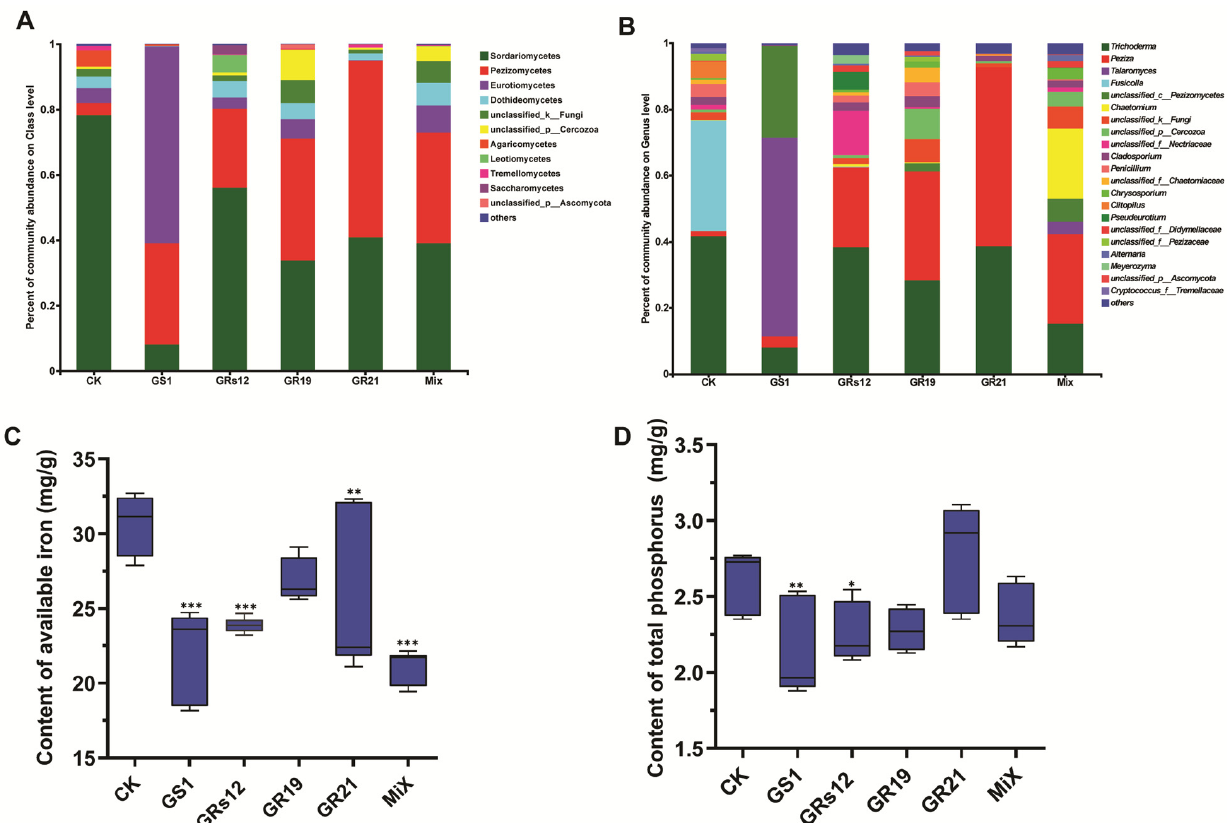
Figure 5. Influence of PGPF on fungal community and physicochemical properties of mulberry rhizosphere soil. ( A ) The fungal community composition at the class level. ( B ) The fungal community composition at the genus level. Taxa with an abundance < 0.01 were included in “others.” Each column represented the mean of three biological replicates. ( C ) Contents of available iron in soils. ( D ) Contents of total phosphorus in soils. GS1, GRs12, GR19, GR21, Mix, and CK represented mulberry seedlings treated with Talaromyces sp. GS1 at the initial concentration, Pseudeurotium sp. GRs12 at the initial concentration, Penicillium sp. GR19 at the 10-fold diluted suspensions, Trichoderma sp. GR21 at the 10-fold diluted suspensions, mixed fungi at the 100-fold diluted suspensions, and water, respectively. Values represented the mean ± standard deviation of replicates ( n = 6). Statistically significant differences between fungi-treated and control groups were analyzed using Dunnett’s one-way analysis of variance. *** p < 0.001, ** p < 0.01, * p <